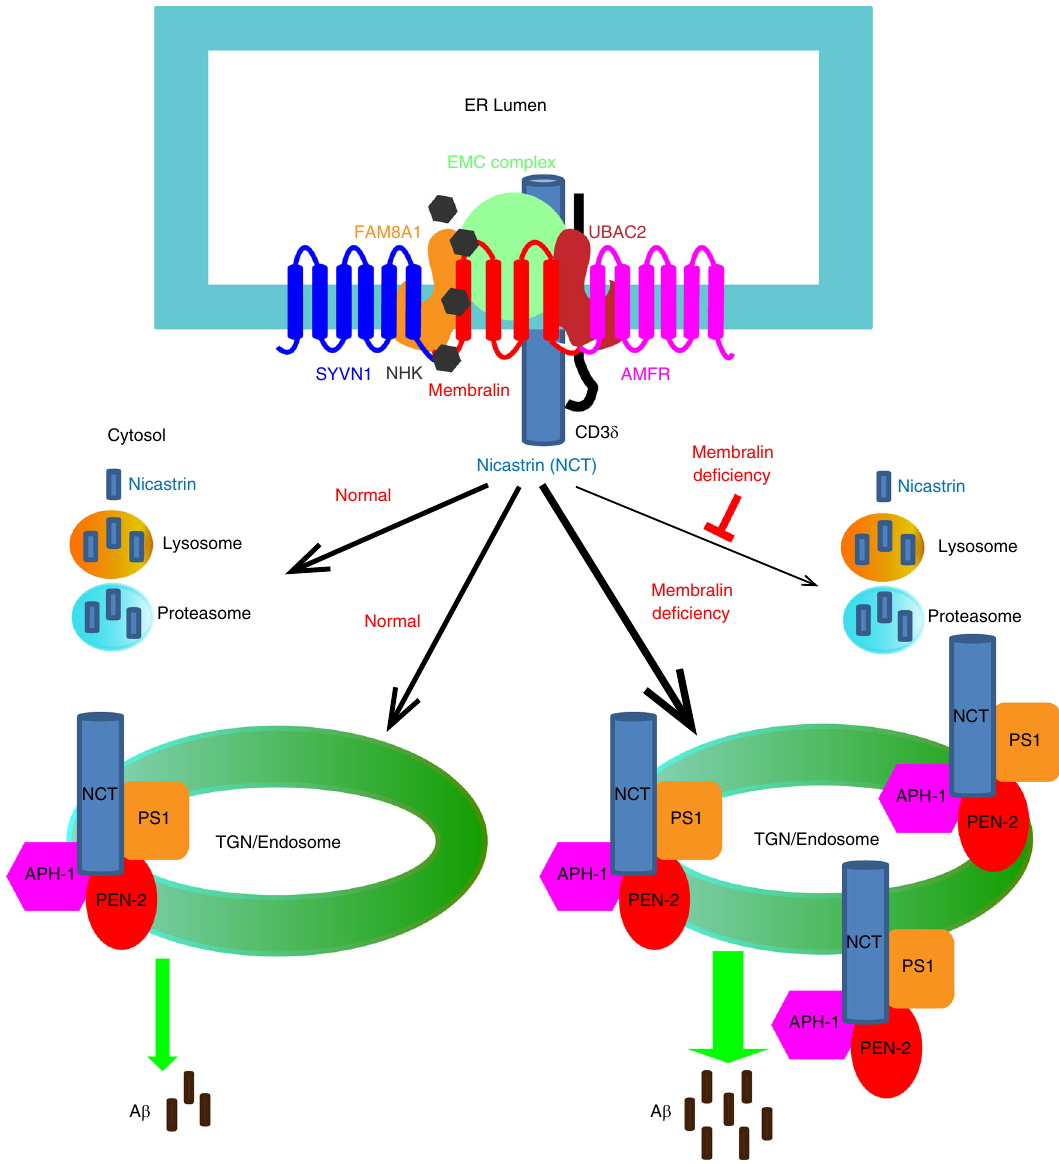
Fig. 8 A schematic model of the ERAD component membralin in regulating nicastrin and A β generation. Membralin interacts with several known ERAD components and mediates nicastrin degradation. Membralin de fi ciency increases nicastrin levels through inhibiting nicastrin degradation, thereby increasing A β